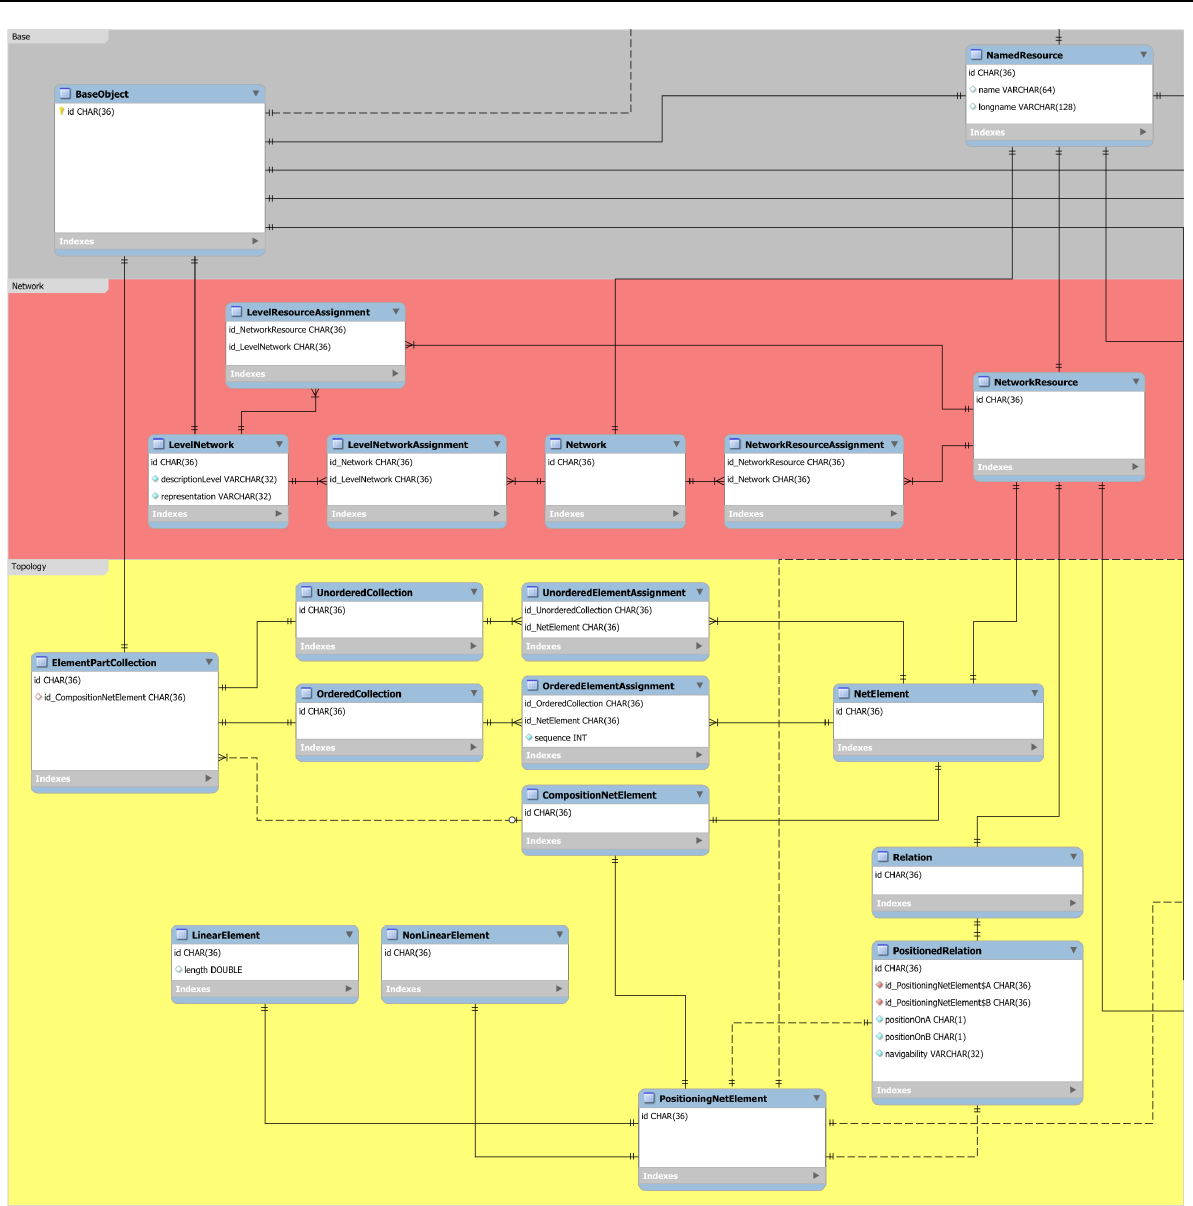
Figure 2. The base, network and topology modules of the Multipurpose Railway Infrastructure Model